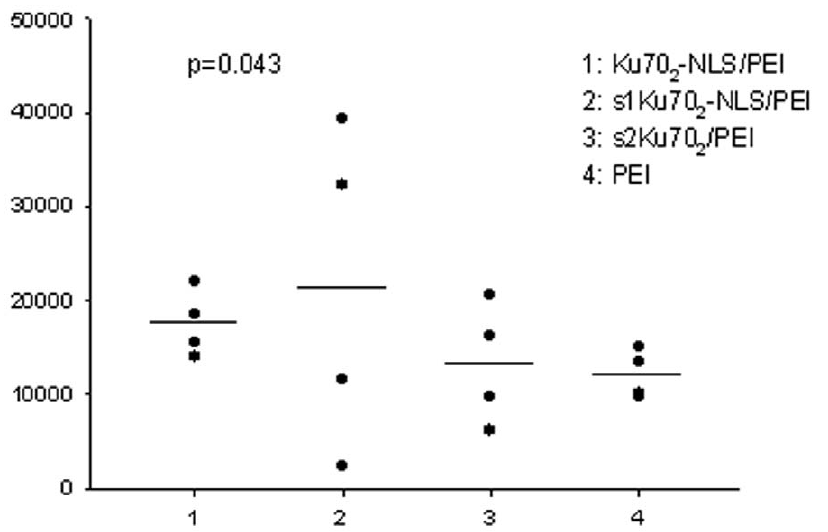
Figure 4. Analysing luciferase expression in lung homogenisates after nasal instillation of gene transfer agents. 1, Ku70 2 -NLS/PEI/ DNA; 2, s1Ku70 2 -NLS/PEI/DNA; 3, s2Ku70 2 /PEI/DNA; 4, PEI/DNA. Gene vector complexes were formulated as follows: 30 m g DNA; NLS: 6 ratio=5; PEI: N/P ratio=10. Luciferase activity was measured in lung homogenisates 24 h after application of gene vectors. Values between Ku70 2 -NLS/PEI and PEI significantly different ( p # 0.043; n=4). Statistical analysis was performed using the Mann-Whithney-U